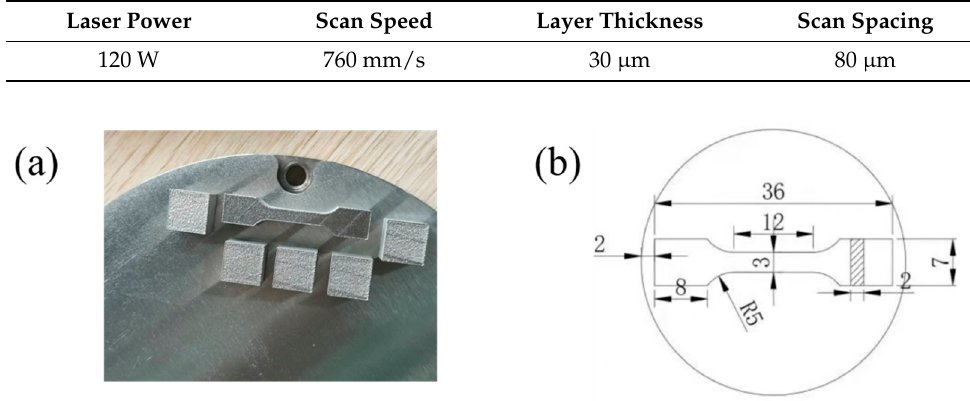
Table 3. LPBF process parameters.